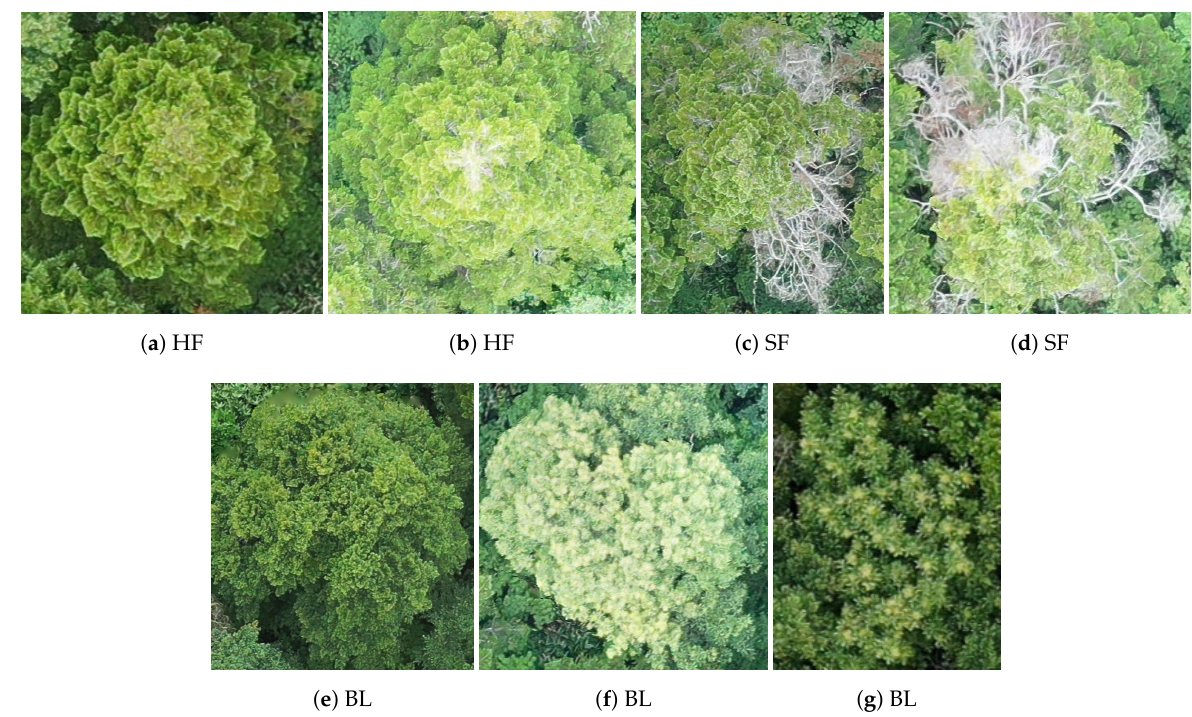
Figure 2. ( a ) healthy fir (HF) fully covered by green leaves; ( b ) healthy fir (HF) with minimal defoliation; ( c ) sick fir (SF) with some leafless branches at the bottom; ( d ) sick fir (SF) with majority of leafless branches ( e – g ) broadleaf (BL) in site 1 and